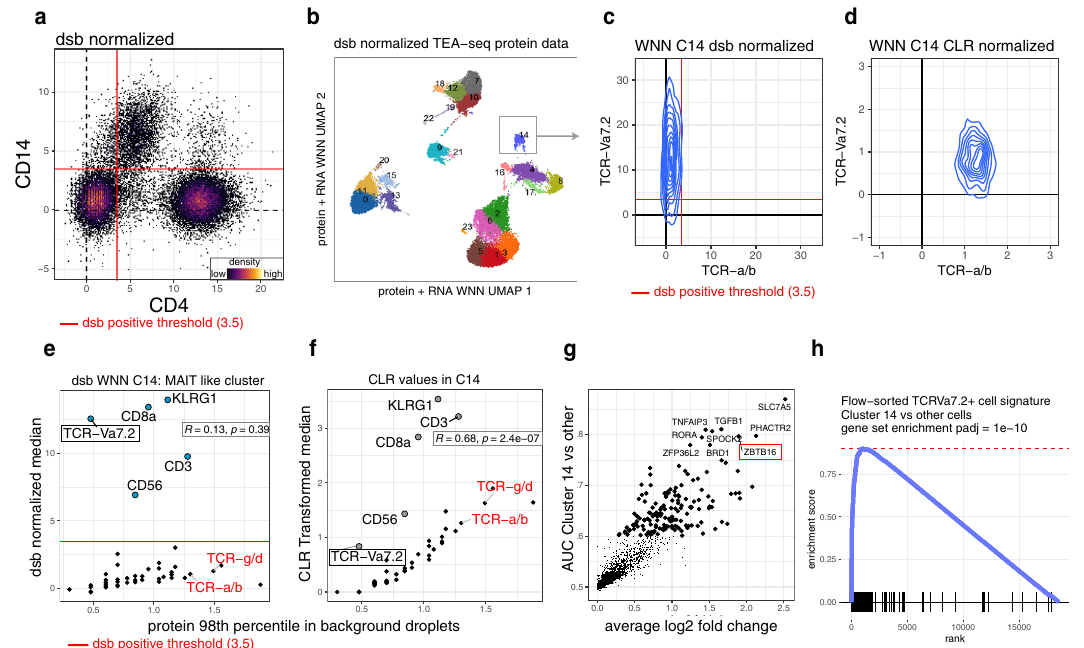
Fig. 4 Case study II: application of dsb to tri-modal TEA-seq data unmasks a MAIT cell population obscured by noise in CLR normalization. Analysis of TEA-seq (transcriptome, epitopes, and accessibility) tri-modal single cell assay data. a dsb normalization of protein data from TEA-seq showing the distribution of CD4 and CD14 with the same 3.5 threshold used throughout the study. b UMAP plot of single cells and clusters derived by WNN joint mRNA – protein clustering with protein data normalized using dsb. c Bi-axial distribution of the alpha beta and va7.2 T cell receptor (TCR) proteins in cluster 14 cells normalized by dsb and d the same cells ’ CLR normalized values. e Similar to Fig. 3g but here for cluster 14 from ( b ) using dsb or f CLR normalized values ( y -axis); in both plots Pearson correlation coef fi cients and p values (two sided) are shown between normalized values ( y axis) and values in empty droplets ( x axis). g Differential expression analysis (ROC test) of genes in cluster 14 vs. other clusters. h Gene set enrichment of a MAIT cell signature constructed from FACS-sorted TCR-va7.2 + /MAIT cells compared to other T cells (RNA-seq data from Park et al. 2019) with genes ranked by log2 fold change in cluster 14 cells vs. other cells as in ( g